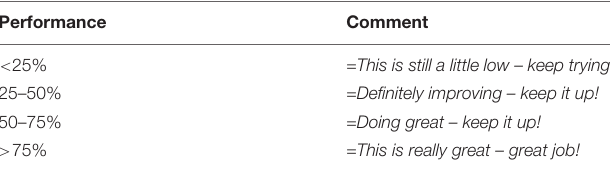
TABLE 2 | Knowledge of results (performance generated